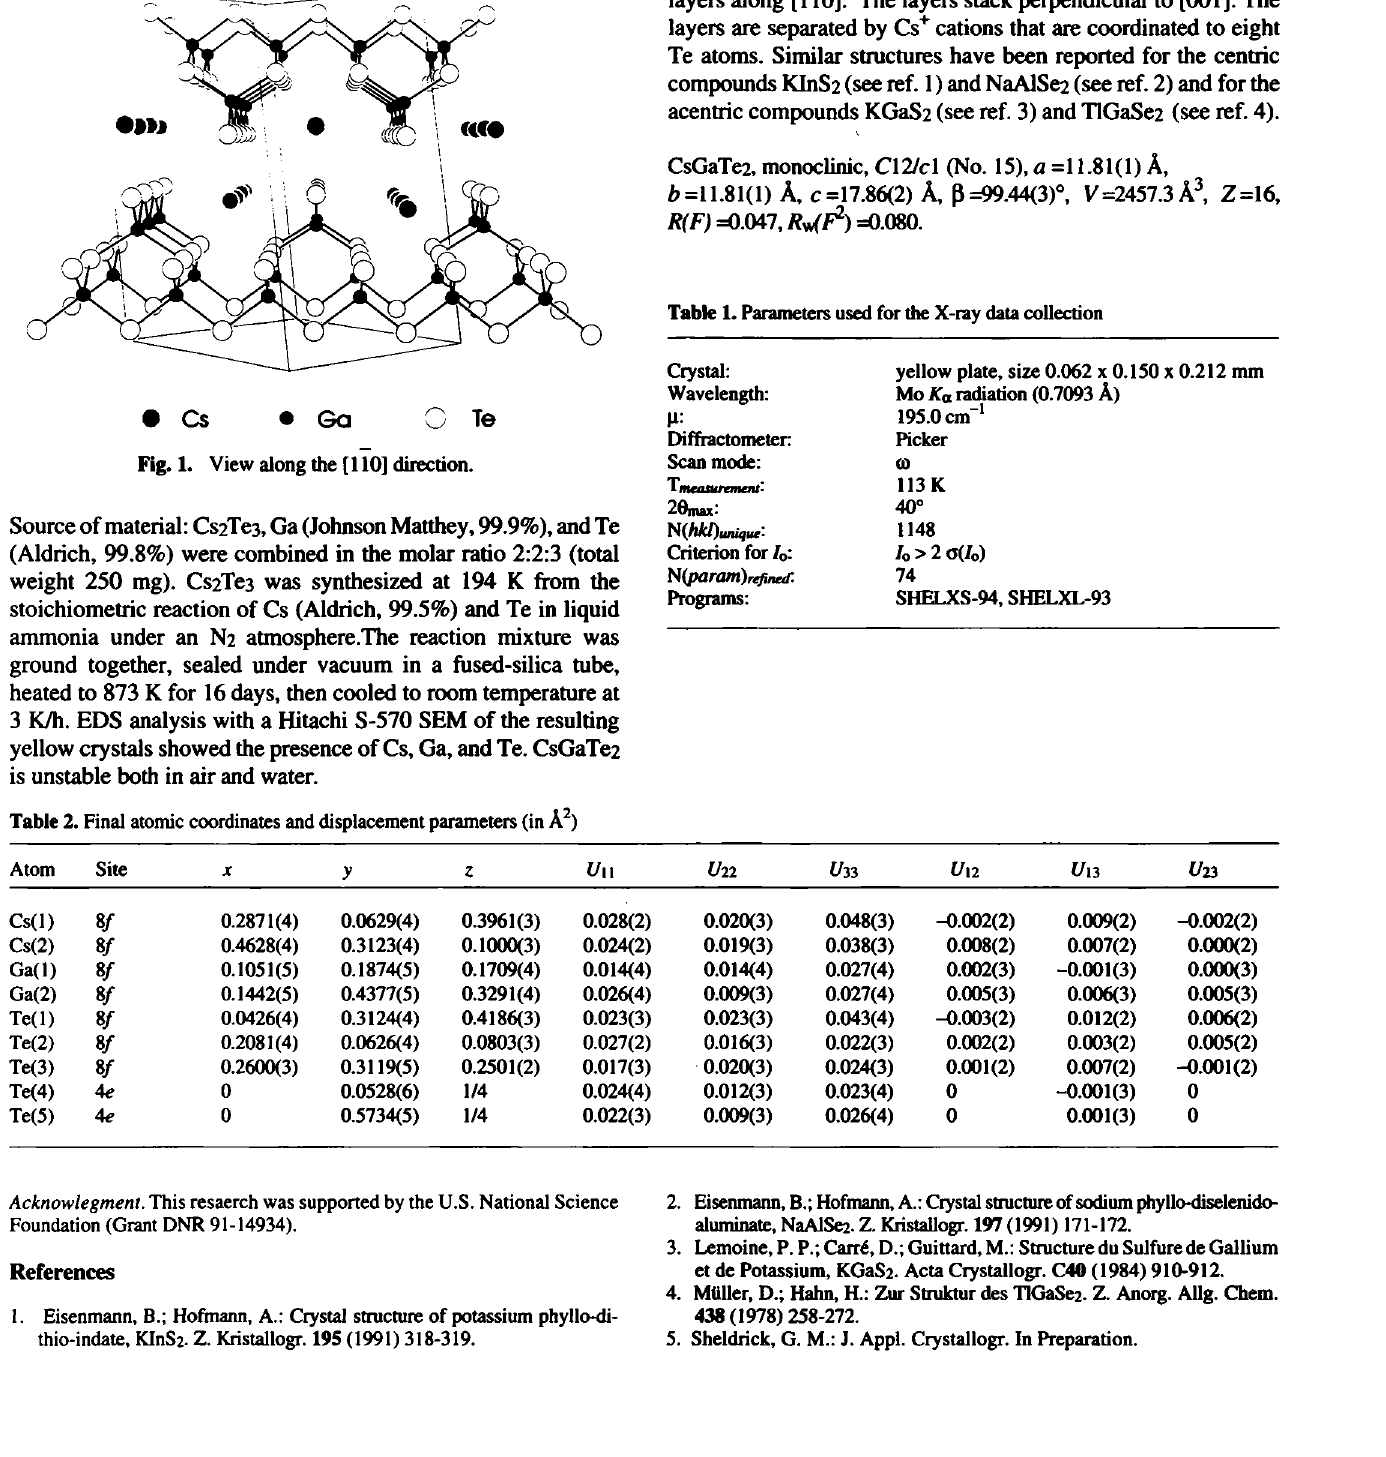
CsGaTe2 consists of adamantane-like Ga+Teio units that form layers along [110]. The layers stack perpendicular to [001]. The layers are separated by Cs + cations that are coordinated to eight Te atoms. Similar structures have been repotted for the centric compounds KInS2 (see réf. 1 ) and NaAlSe2 (see ref. 2) and for the acentric compounds KGaS2 (see ref. 3) and TlGaSe2 (see ref. 4).